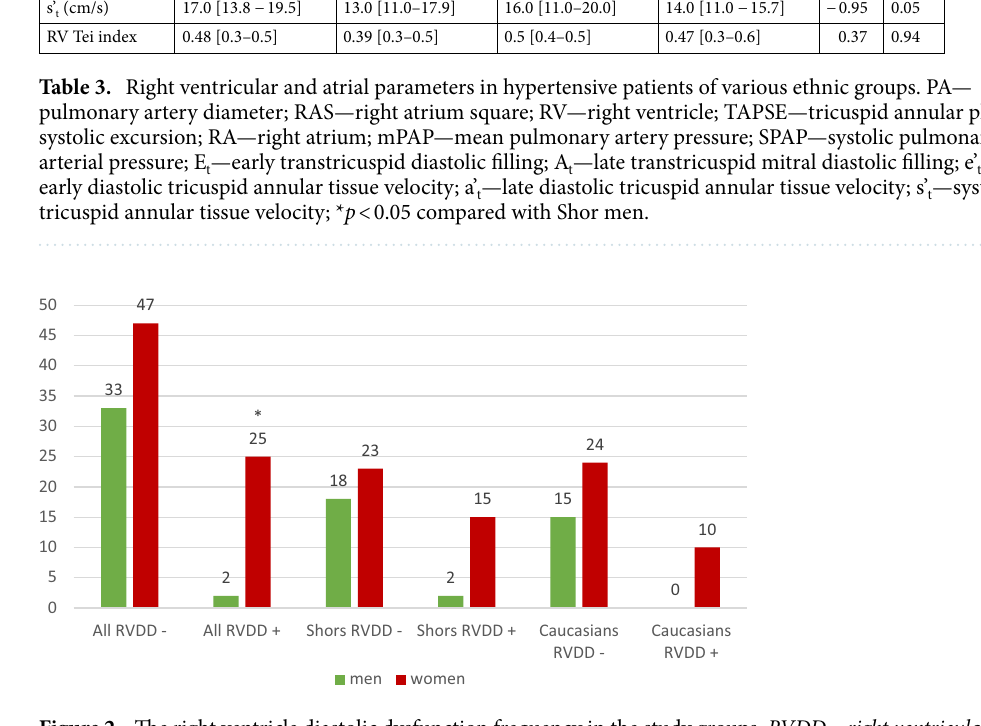
In a univariate binary logistic regression including of all variables (Table 4), the following factors had a significant association with the right ventricle diastolic dysfunction ( χ 2(24) = 62.5, p < 0.001): ethnicity, sex, smoking, body mass index, obesity, systolic blood pressure, urea, LVMM index, diastolic LV function (e’/a’, E/e’). The model explained 67.8% (Nagelkerke R2) of the variance in RVDD and correctly classified 90.1% of cases. In multiple binary logistic regression model (forward LR method), sex was the only significant factor included in the model ( χ 2 = 11.8, p < 0.001), but this model explained only 16.2% (Nagelkerke R2) of the variance in RVDD and correctly classified 74.3% of cases. Nevertheless, despite the reliable statistical significance of the latter model, its low quality (judging by the Nagelkerke R2 indicator) does not allow us to reject univariate analysis with other indicators associated with RVDD in , in particular, the ethnicity of the patients. ROC-curves of the studied left ventricular variables (LVMMi, LVEF, ratio E/A and e’/a’) association with RVDD are presented in Fig. 3. The areas under the curves were below 0.7 (for e’/a’—0.682, for LVEF—0.620, for E/A—0.557, and for LVMMi—0.556), which indicated an inability of these to identify RVDD. Among the right